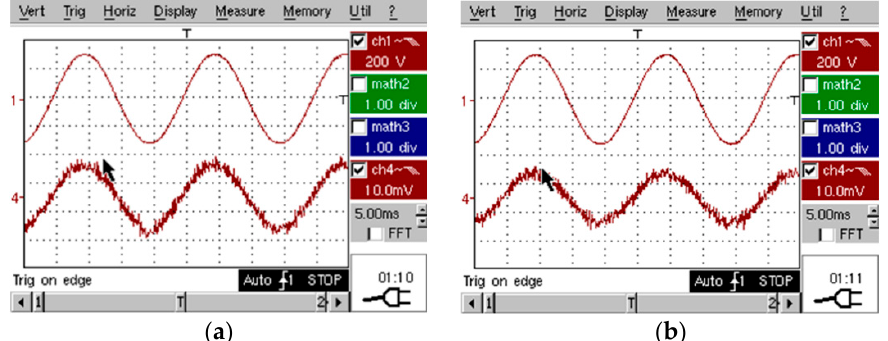
Figure 20. Oscillograms of voltages and currents on phase A ( a ) and phase B ( b ), upstream of the PCC.